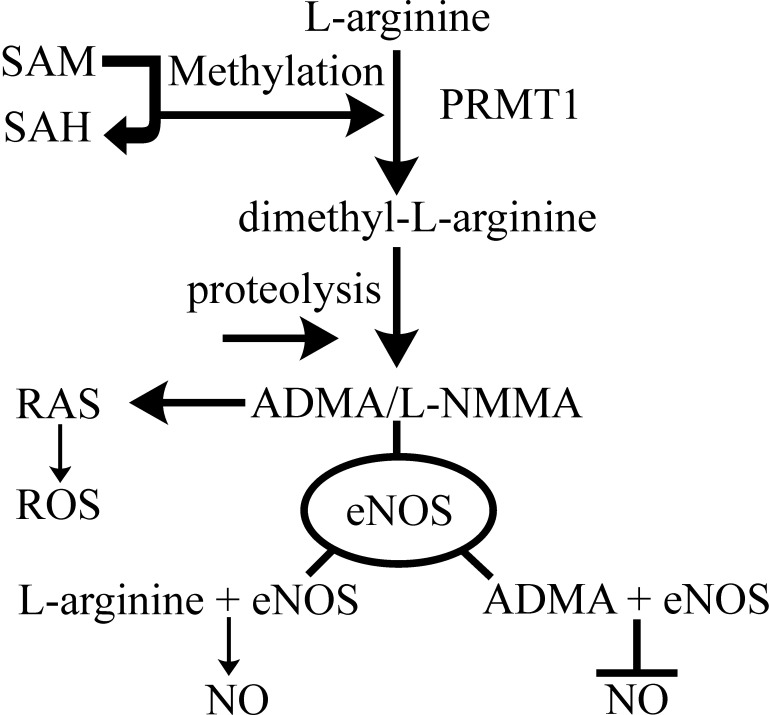
ADMA pathway and its relationship with NO. ADMA: asymmetric dimethylarginine; SAM: S-adenosylmethionine; SAH: S-adenosylhomocysteine hydrolase; PRMT1: enzyme methyltransferase type 1; SDMA: symmetrical dimethylarginine; L-NMMA: NG-monomethyl-L-arginine; RAS: renin-angiotensin system; ROS: reactive oxygen species; eNOS: endothelial nitric oxide synthase enzyme; NO: nitric oxide synthesis.